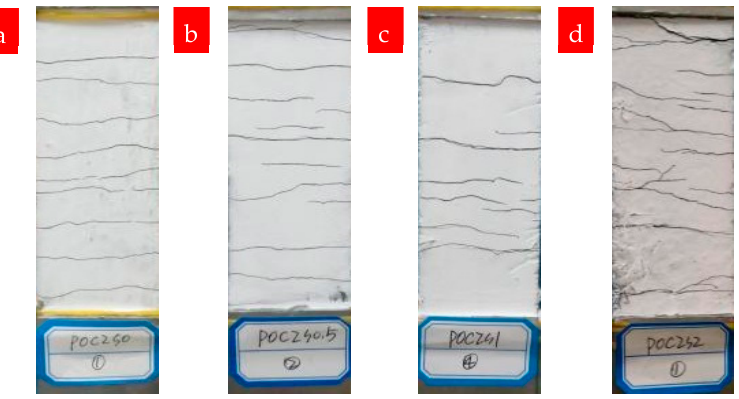
Figure 13. Cracking in TRM specimens with different volume fractions of steel fibers: ( a ) P0C2S0, ( b ) P0C2S0.5, ( c ) P0C2S1, and ( d ) P0C2S2.